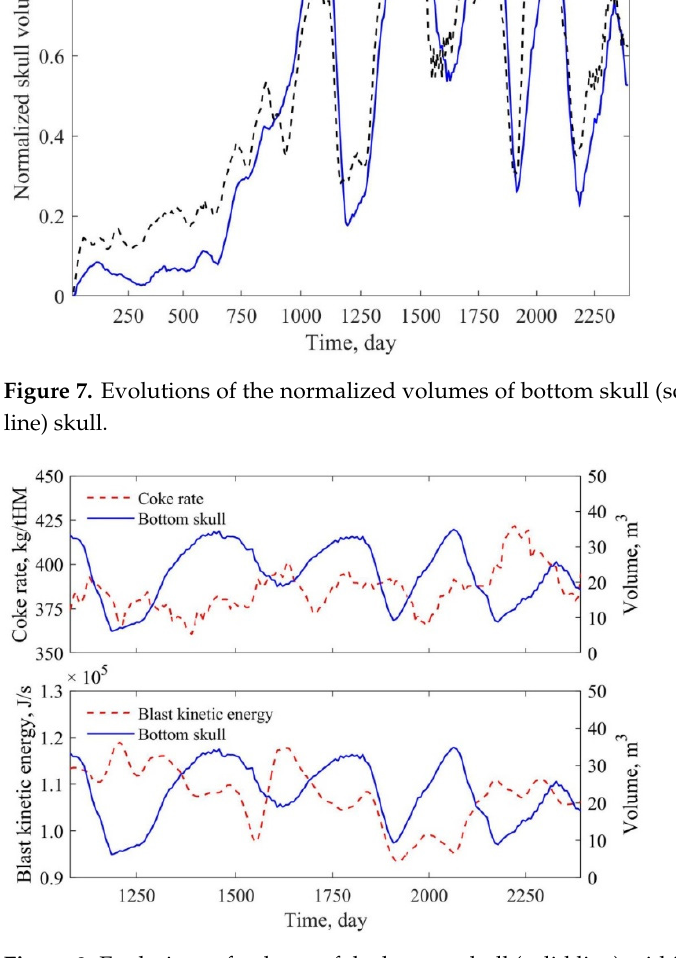
Figure 8. Evolutions of volume of the bottom skull (solid line) within the hearth, coke rate (dashed line, upper panel), and blast kinetic energy (dashed line, lower panel) of the blast furnace.